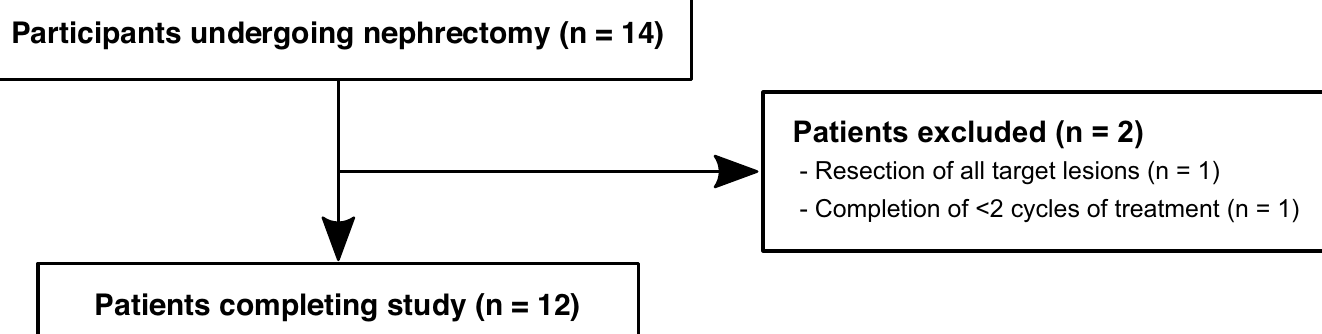
Fig 1. CONSORT diagram explaining recruitment and reasons for exclusion of